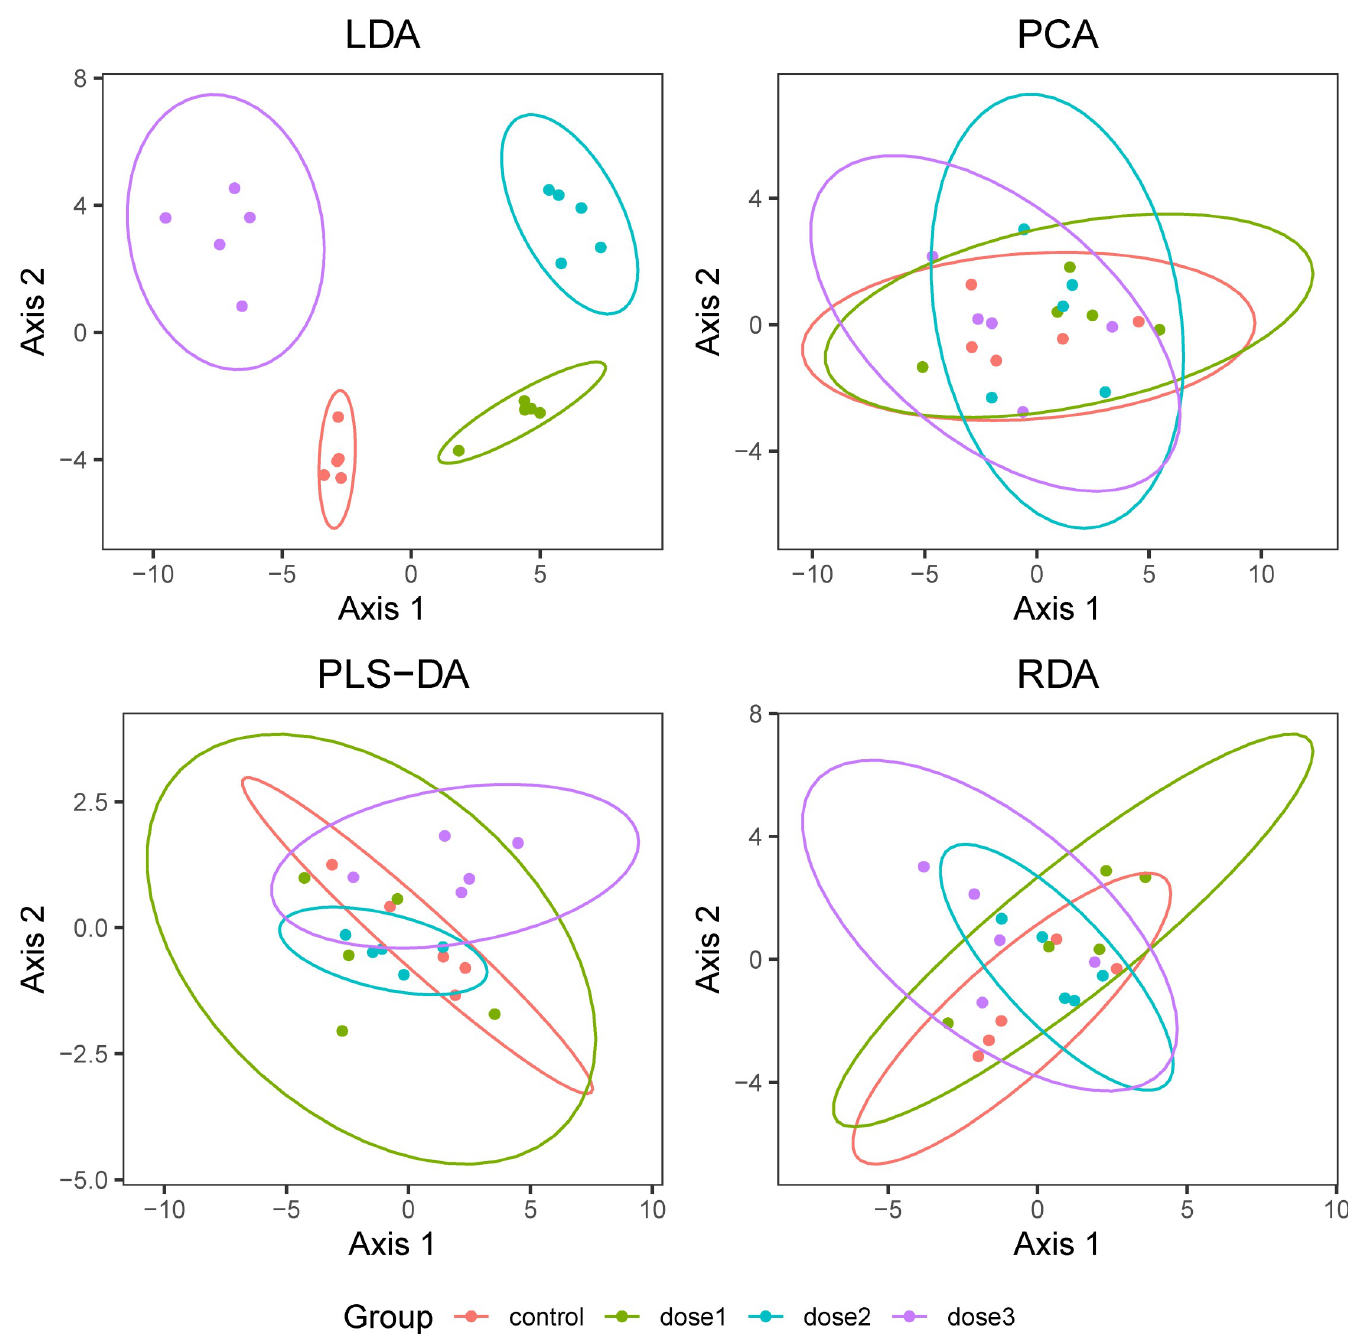
Fig 6. Comparison of ordination techniques for pattern analysis in the case when no treatment effects were simulated. Plots show results for one out of 1000 simulations with 5 measurements per group drawn from a multivariate normal distribution with equal variance between control and treatment groups. The ordination technique was considered to falsely capture a treatment effect pattern in the data in case of non-overlapping 95% confidence ellipse of the control group with the confidence ellipses for the treatment groups (dose1 to dose3). LDA: Linear discriminant analysis; PCA: Principal component analysis; PLS-DA: Partial least squares discriminant analysis; RDA; Redundancy